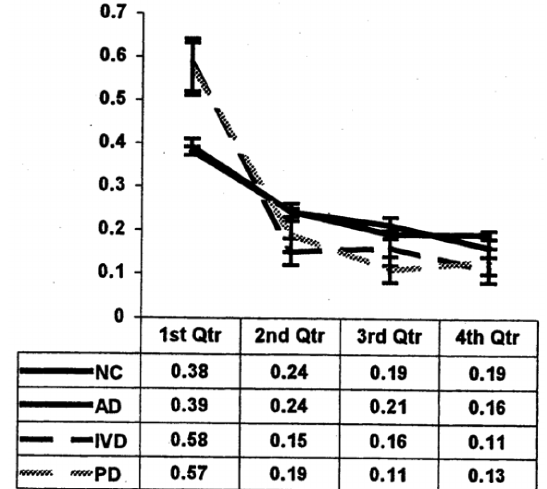
Fig. 2. The proportion of letter ‘S’ output per 15 second epoch by subject group (NC = normal control; AD = Alzheimer’s disease; IVD; = ischaemic vascular dementia; PD = Parkinson’s disease with